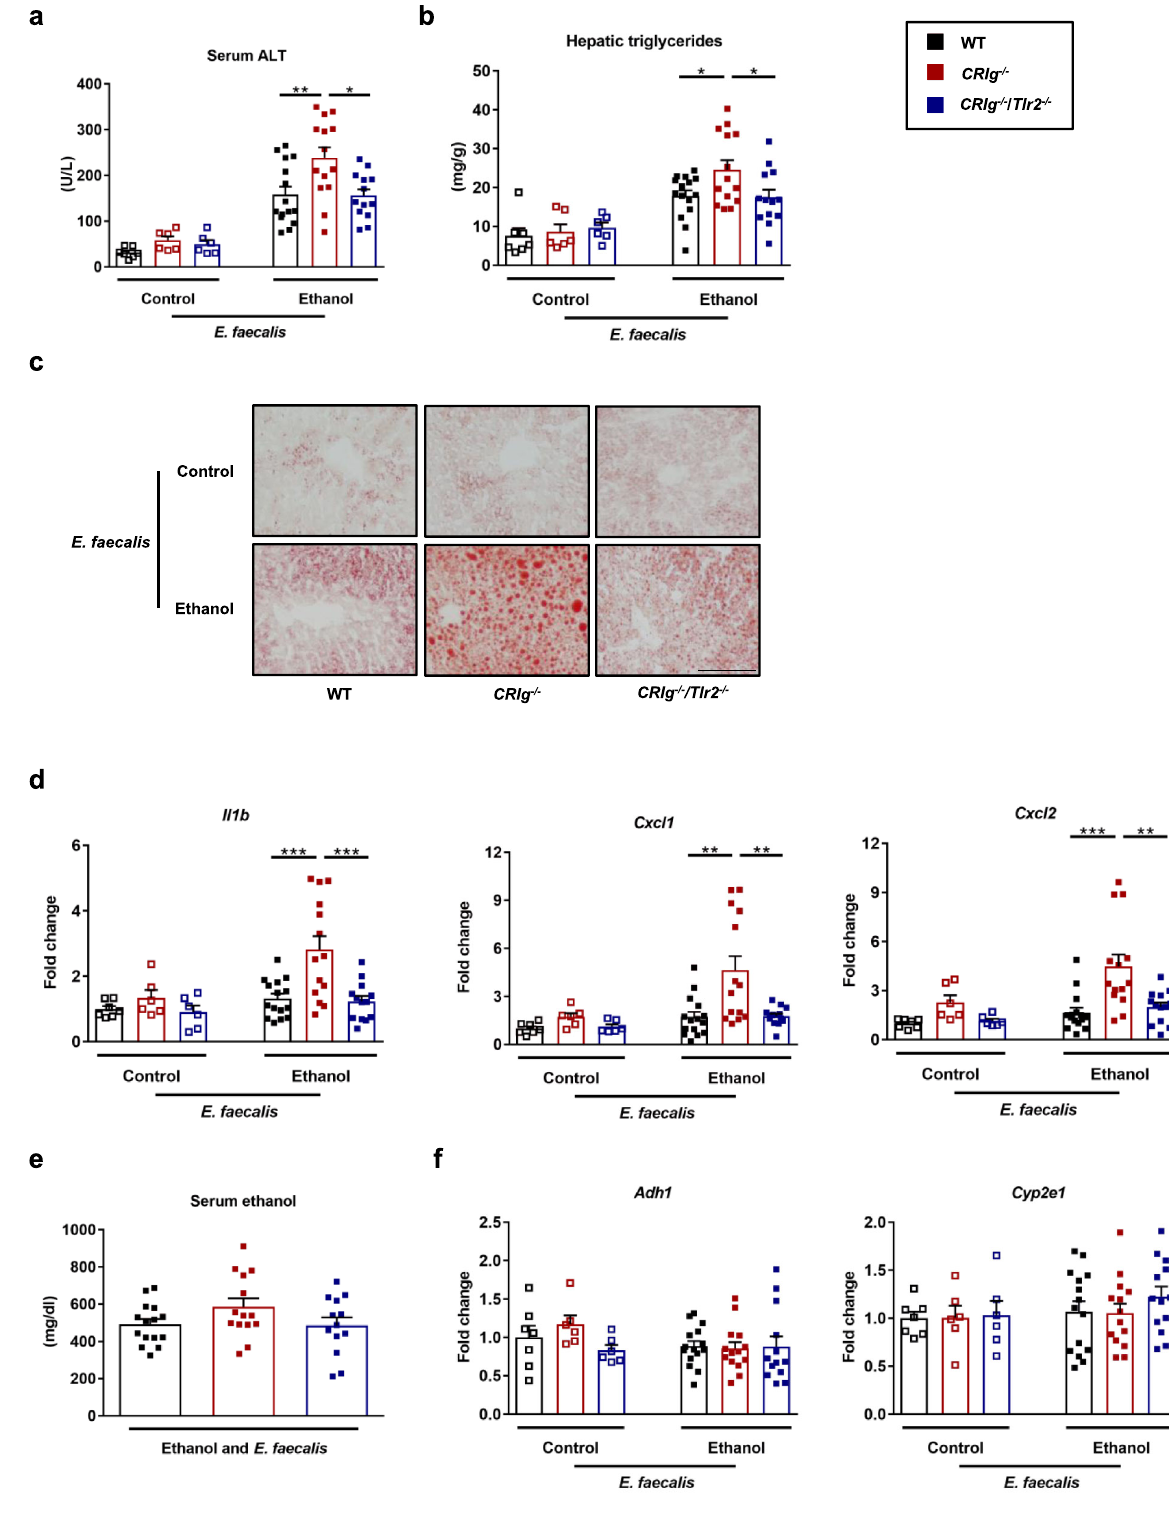
Fig. 3 CRIg − / − mice are more susceptible to E. faecalis- and ethanol-induced liver disease. WT, CRIg − / − and CRIg − / − / Tlr2 − / − mice were placed on the chronic – binge ethanol diet and gavaged with a cytolytic E. faecalis strain (5 × 10 8 colony forming units (CFUs)) every third day. a Serum levels of ALT. b Hepatic triglyceride content. c Representative oil red O-stained liver sections. d Hepatic levels of mRNAs encoding in fl ammatory cytokines and chemokines IL1B, CXCL1, and CXCL2. e Serum levels of ethanol in ethanol-fed mice. f Hepatic levels of Adh1 and Cyp2e1 mRNAs. Scale bar = 100 μ m. Results are expressed as mean ± s.e.m. ( a , b , d – f ). P values among groups of mice fed with control diet or ethanol diet are determined by one-way ANOVA with Tukey´s post-hoc test ( a , b , d – f ). * P < 0.05, ** P < 0.01, *** P <